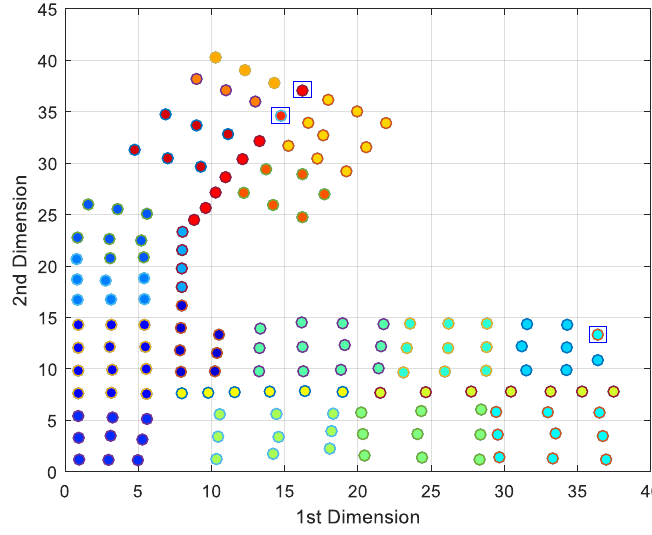
ff ect of regional Figure 7. Effect of regional division. Figure 7. E